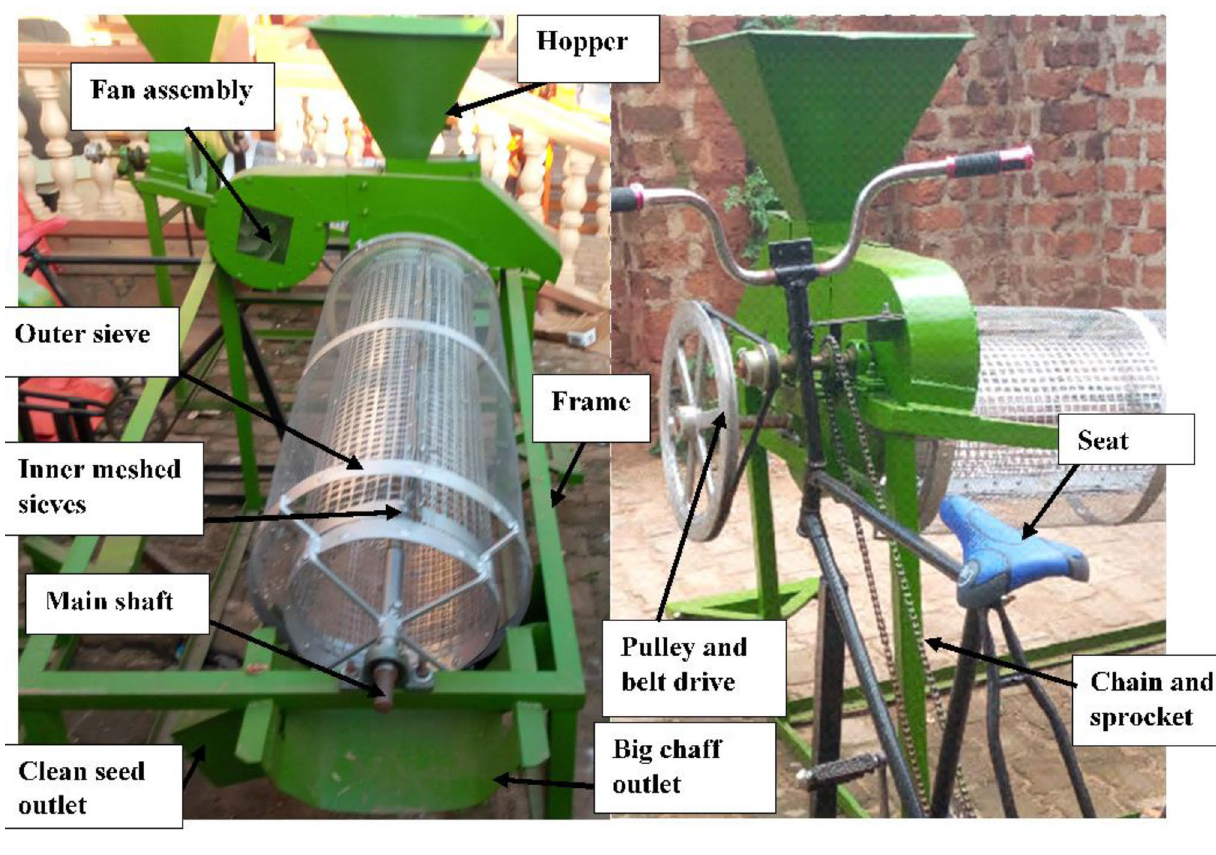
Fig. 1 Assembly of the Pedal Operated Seed Cleaner